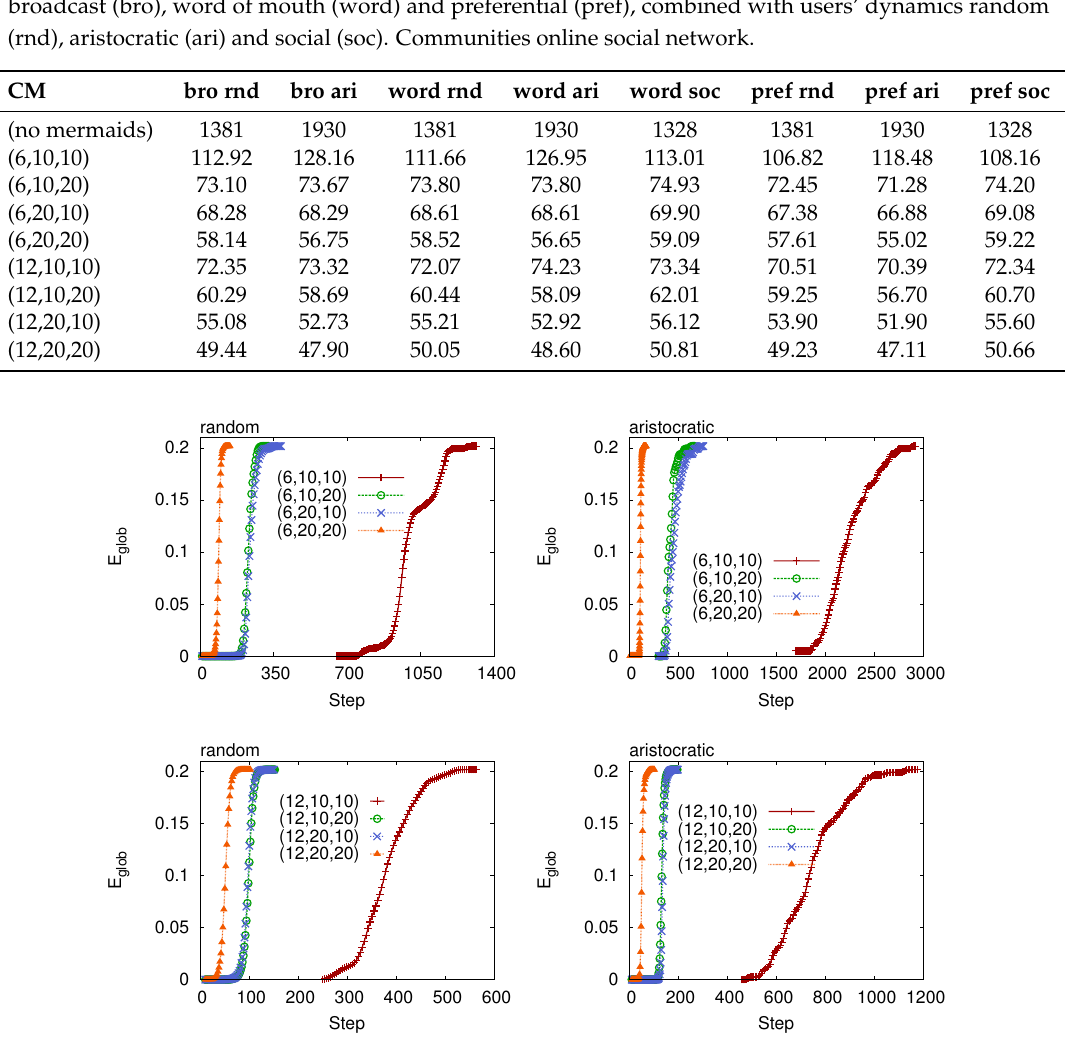
Figure 20. Effect on parameters’ variation on the configurations fixing the number of mermaids to m = 6 ( top panels ) and m = 12 ( bottom panels ). Four cost levels are then considered in each plot, from 600 to 4800. Broadcast model , VirtualTourist online social